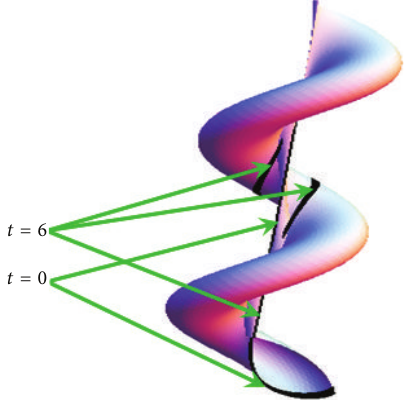
= 0.8 , and 𝑐 = 0.5 . 1 2